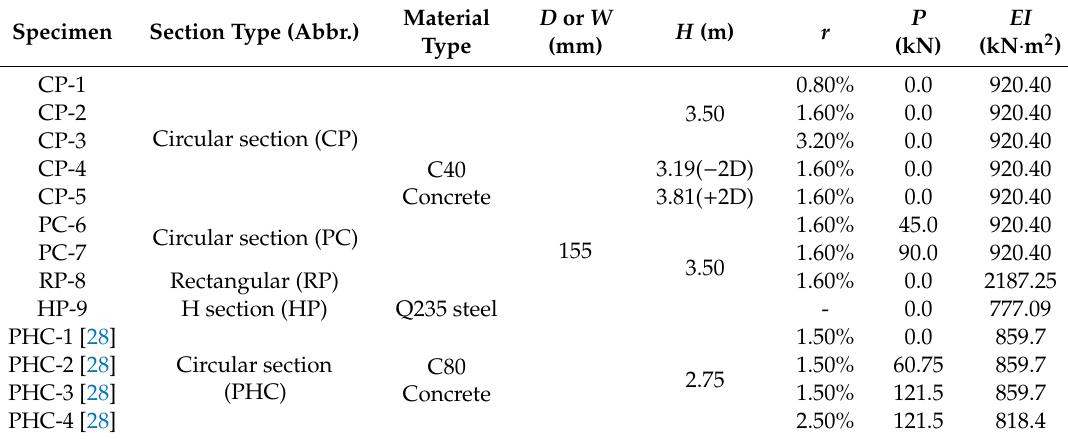
Table 2. Design parameters of all specimens.